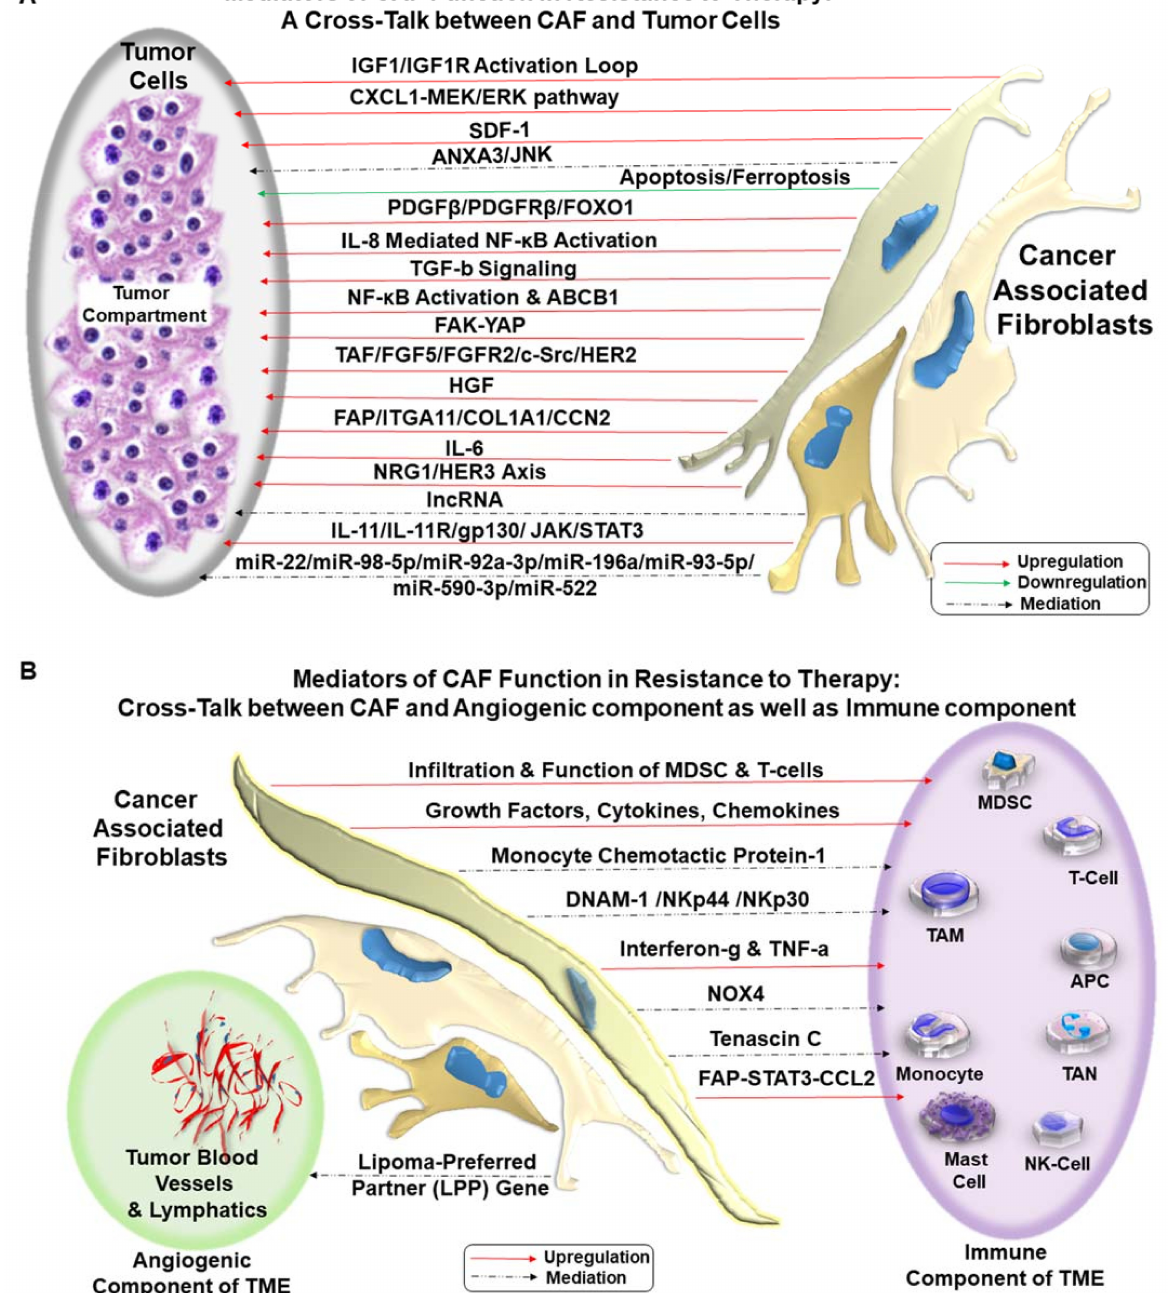
Figure 2. Mediators of CAF functions in the development of resistance to therapy: The development of resistance to various treatments involves dialogues of CAF with (1) tumor cells (CAF-tumor cell crosstalk), (2) tumor-infiltrating immune cells (CAF-immune cell crosstalk), and (3) endothelial cells (CAF-angiogenic cell crosstalk). CAF plays a critical role in the development of resistance to therapy in solid tumors. The CAF-tumor cell crosstalk occurs via several mechanisms involving upregulation (Red Arrow), downregulation (Green Arrow), and complex mediation (Broken Arrow) of signals in different solid tumors. Several cell signaling pathways are upregulated in the CAF-tumor cell crosstalk, including IGF, HGF-cMET, MEK-ERK, JNK, PDGF, NF kappaB, NRG1-HER3, FGFR/c-SRC, and JAK-STAT3 pathways. The crosstalk also involves several miRNAs, including miR-22, miR-98-5p, miR-92a-3p, miR-196a, miR-93-5p, miR-590-3p, miR-522, as well as cytokines like IL-6, IL-11, SDF-1, and TGFbeta. CAF also downregulated apoptosis and ferroptosis of tumor cells ( A ). CAF interacts directly with the angiogenic component and immune component in the development of resistance to therapy